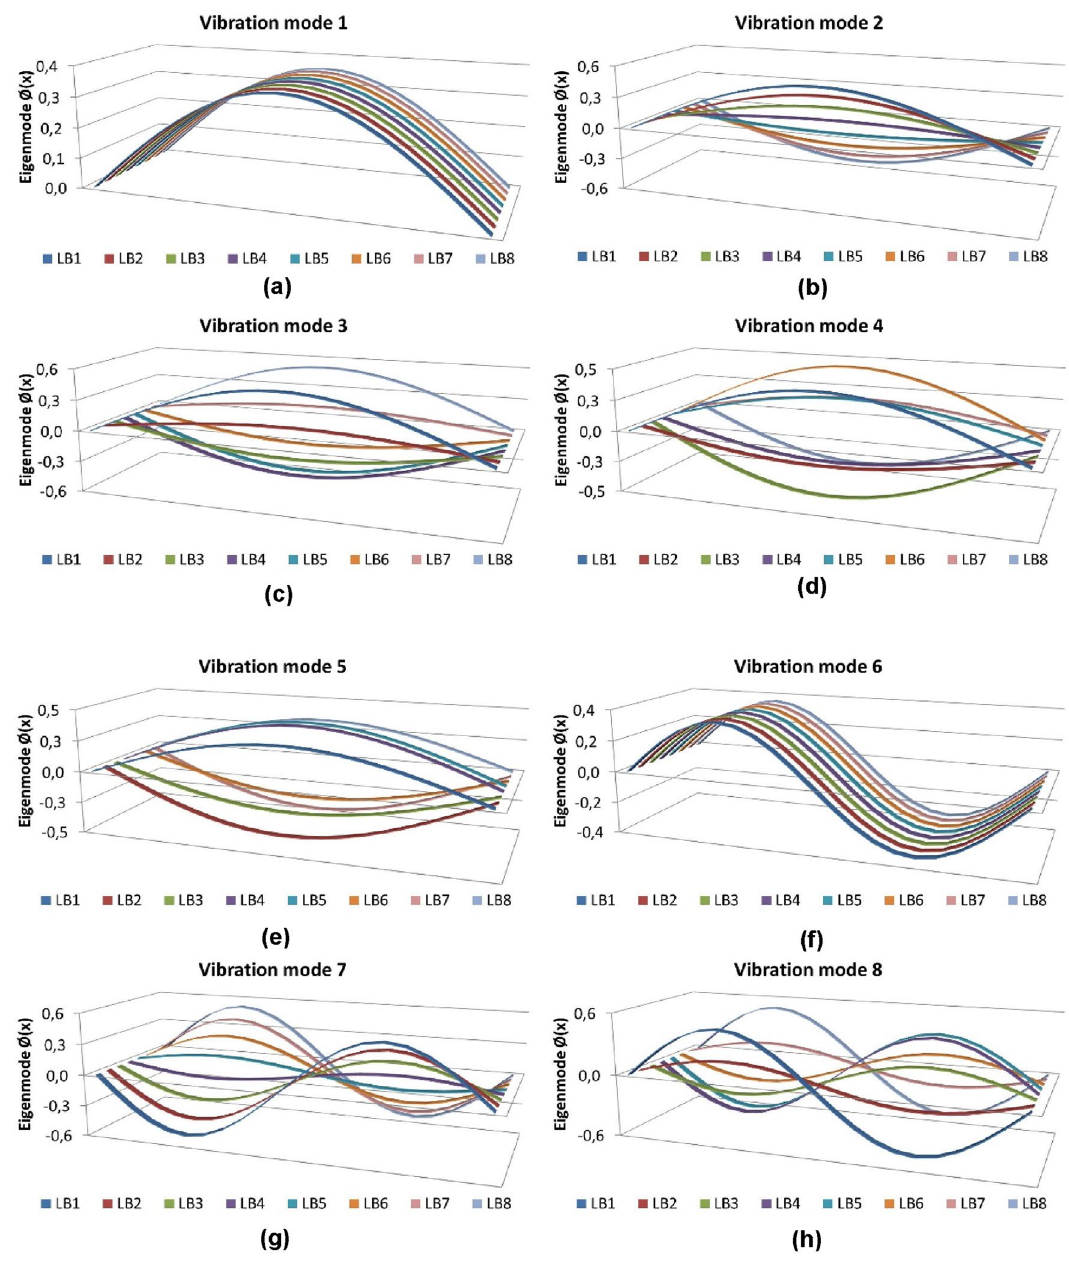
Figure 16. Modal analysis using the methodology proposed by the authors: ( a ) eigenmode function 1; ( b ) eigenmode function 2; ( c ) eigenmode function 3; ( d ) eigenmode function 4; ( e ) eigenmode function 5; ( f ) eigenmode function 6; ( g ) eigenmode function 7; ( h ) eigenmode function